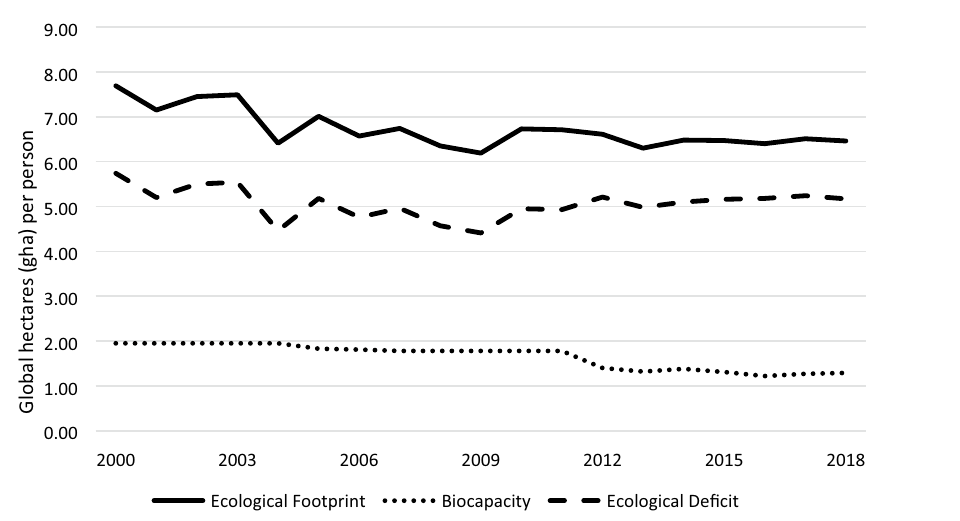
Figure 3. Changes in Taiwan’s EF, biocapacity, and ecological deficit from 2000 to